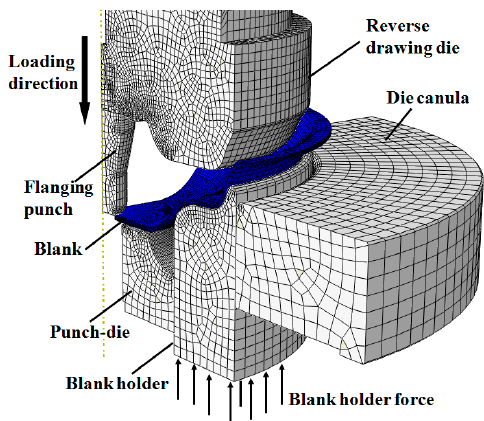
Figure 5. 3D FE model of B550CL spoke reverse drawing–flanging combined process.